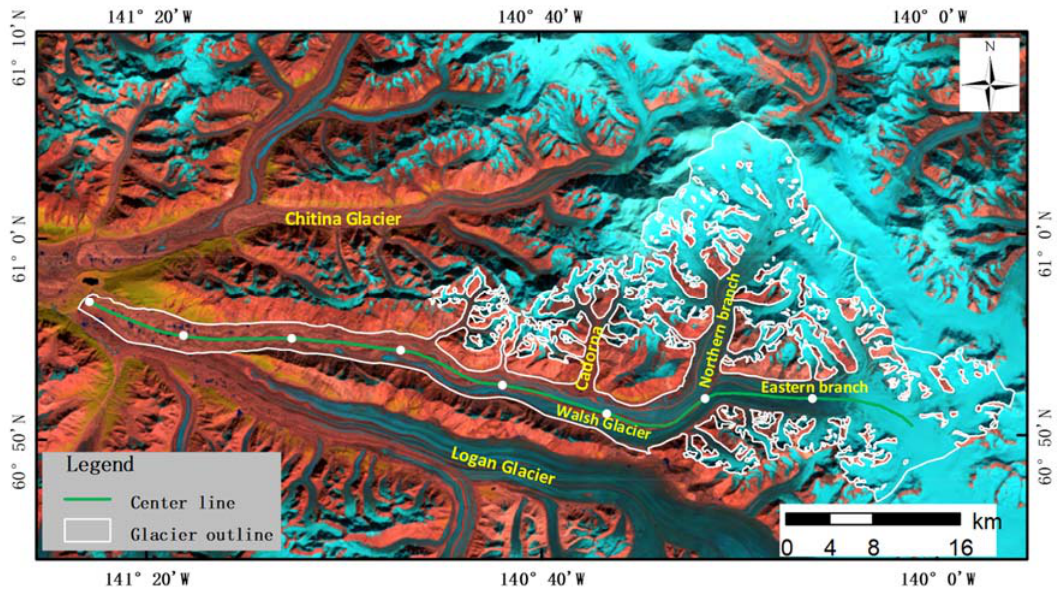
Figure 1. Landsat 8 image (bands 6, 5 and 4 combined) of Walsh Glacier on 11 August 2013, superimposed with the Glacier boundary and manually delineated centerline. The white dots mark 10 km intervals from the terminus.